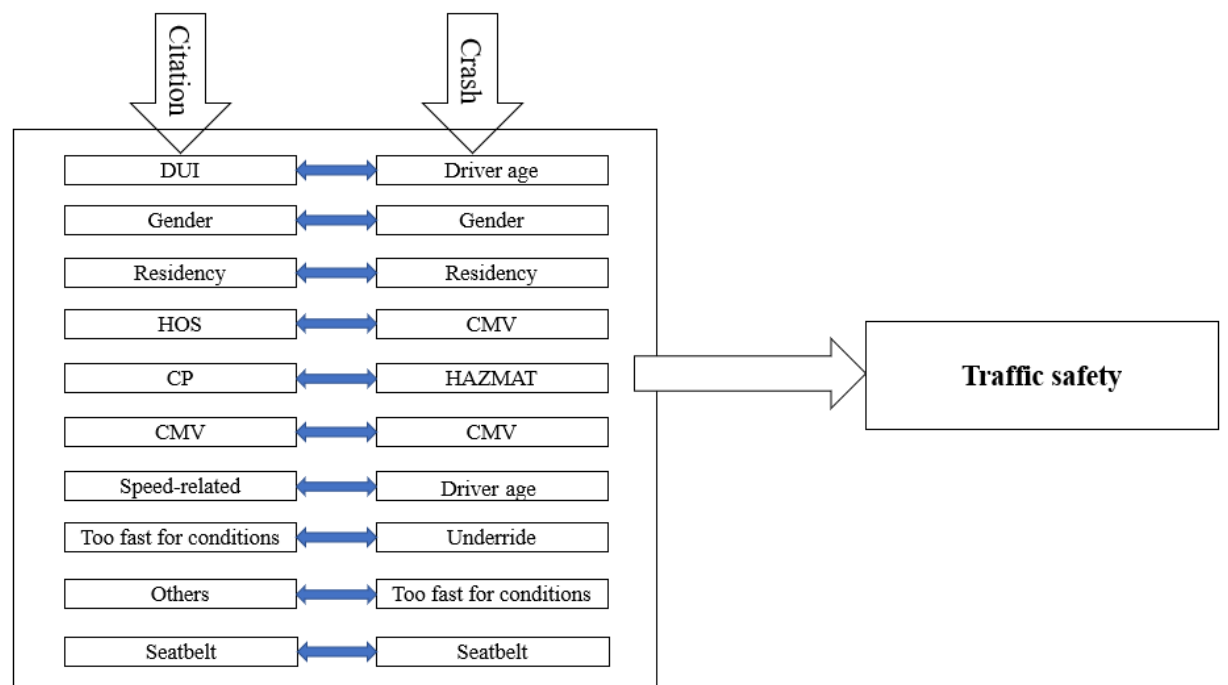
Figure 1. Important interaction terms across citations and crash characteristics.